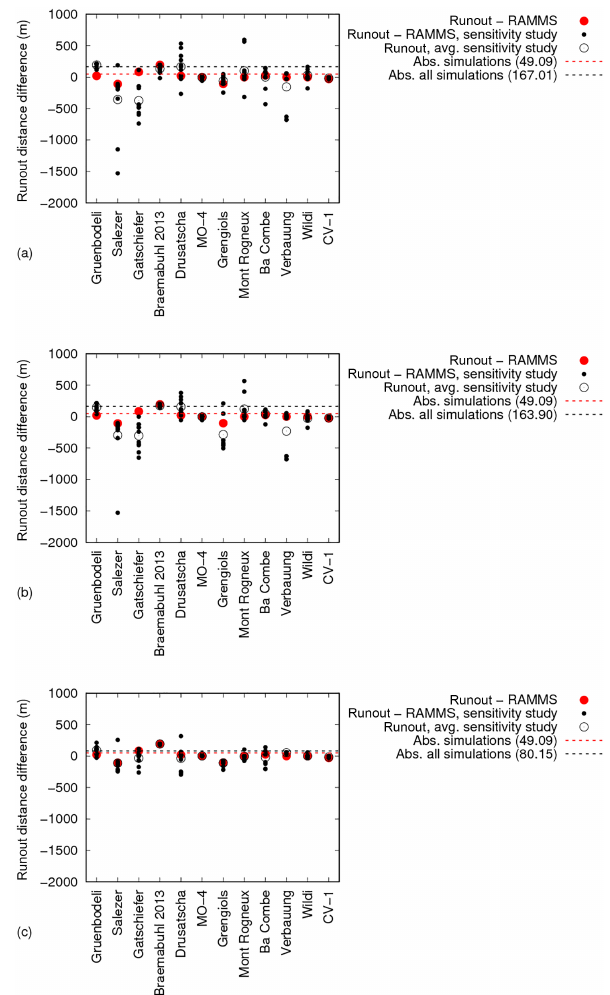
Figure 11. Difference between simulated and measured runout dis- tance for the wet-snow model simulations with the corresponding initial conditions (red dots) and permutations (black dots). The av- erage of the 11 permutations is depicted as a black open circle. (a) Varying both snow mass (fracture height and density) and snow properties (temperature and LWC), (b) varying snow mass only and (c) varying snow properties only. The red and black lines show the average absolute error in meters of the whole set of simulations (sensitivity and real simulations) to the runout distance measured in the